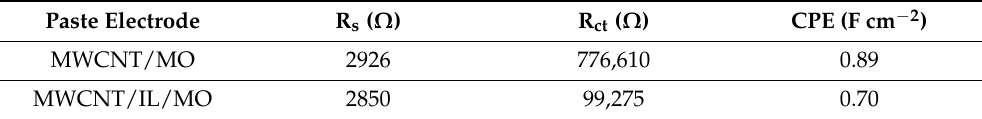
Figure 2. Nyquist diagram for the MWCNTIL/MO and MWCNT/MO systems in 5 mmol L − 1 solution of sulfite in BRB (pH 1.81). Frequencies: 100,000 Hz–1 Hz. Impedance performed at a potential of -0.5 V. Table 2. Values of R s , R ct , and CPE obtained from the equivalent circuit of scheme 1 for the paste electrodes.